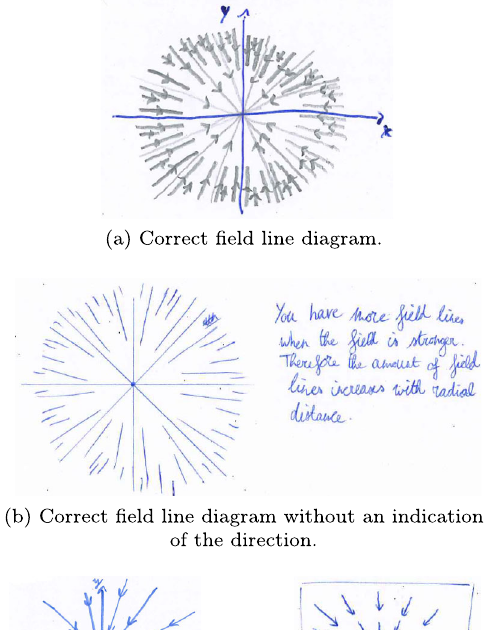
FIG. 11. Post-test question that evaluates students ’ computa- tional skills and their ability to construct a field line diagram. post-test question in Fig. 11. The majority of the students solved parts (a) and (b) by imposing the conditions ∇ × E ¼ 0 and ∇ · B ¼ 0 , respectively. Over the years, the percentage of correct answers increased from 70% to 90%. This confirms that students ’ operational conceptions were developed relatively well. Students struggled to sketch field line diagrams of vector fields with a nonzero divergence at every location. In Fig. 12, some typical responses are shown: a correct field line diagram [Fig. 12(a)], a correct field line diagram without an indication of the direction [Fig. 12(b)], an incorrect field line diagram which resembles the electric